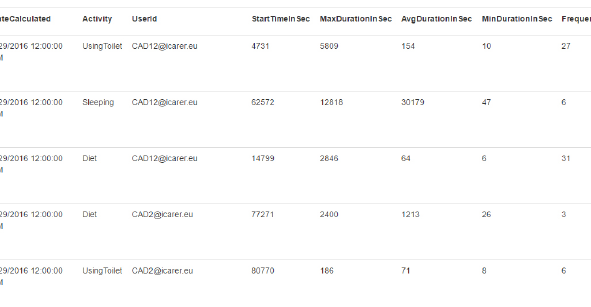
Figure 6. Summary of the individual activities of daily